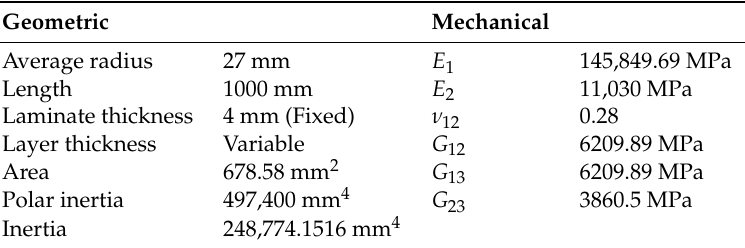
Table 1. Geometric and mechanical